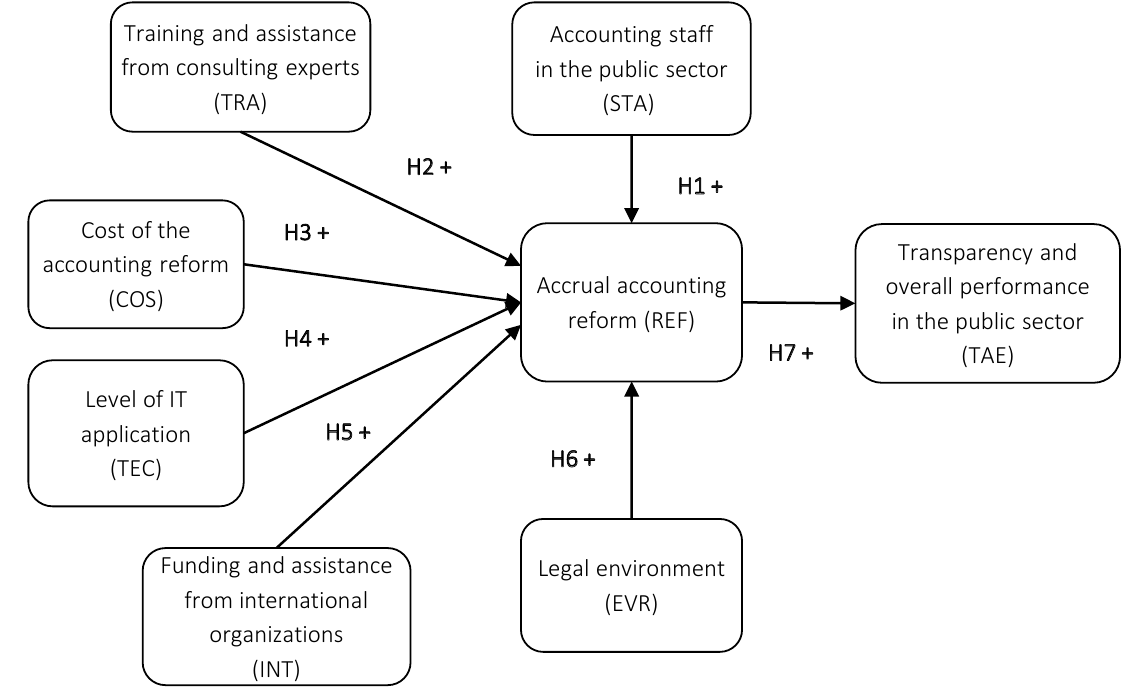
Figure 1. Conceptual